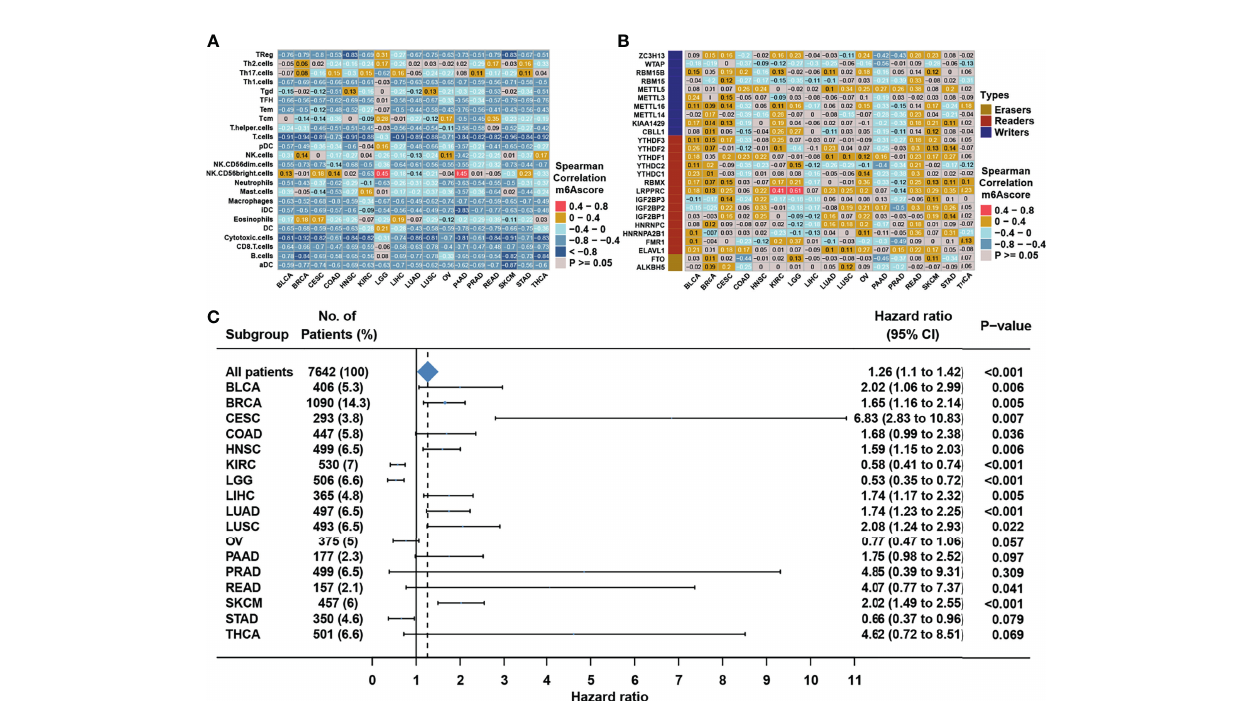
FIGURE 8 | m6A modi fi cation patterns in pan-cancer. (A) Correlation analysis between m6A score and TME in fi ltration cell assessed by immune cell signature 1 using Spearman analysis in the TCGA pan cancer. (B) Correlation analysis between m6A score and m6A regulators using Spearman analysis in the TCGA pan cancer. (C) Subgroup analyses estimating prognostic value of m6A score in different cancer types from the TCGA datasets. HR >1.0 indicated that high m6A score was an unfavorable prognostic